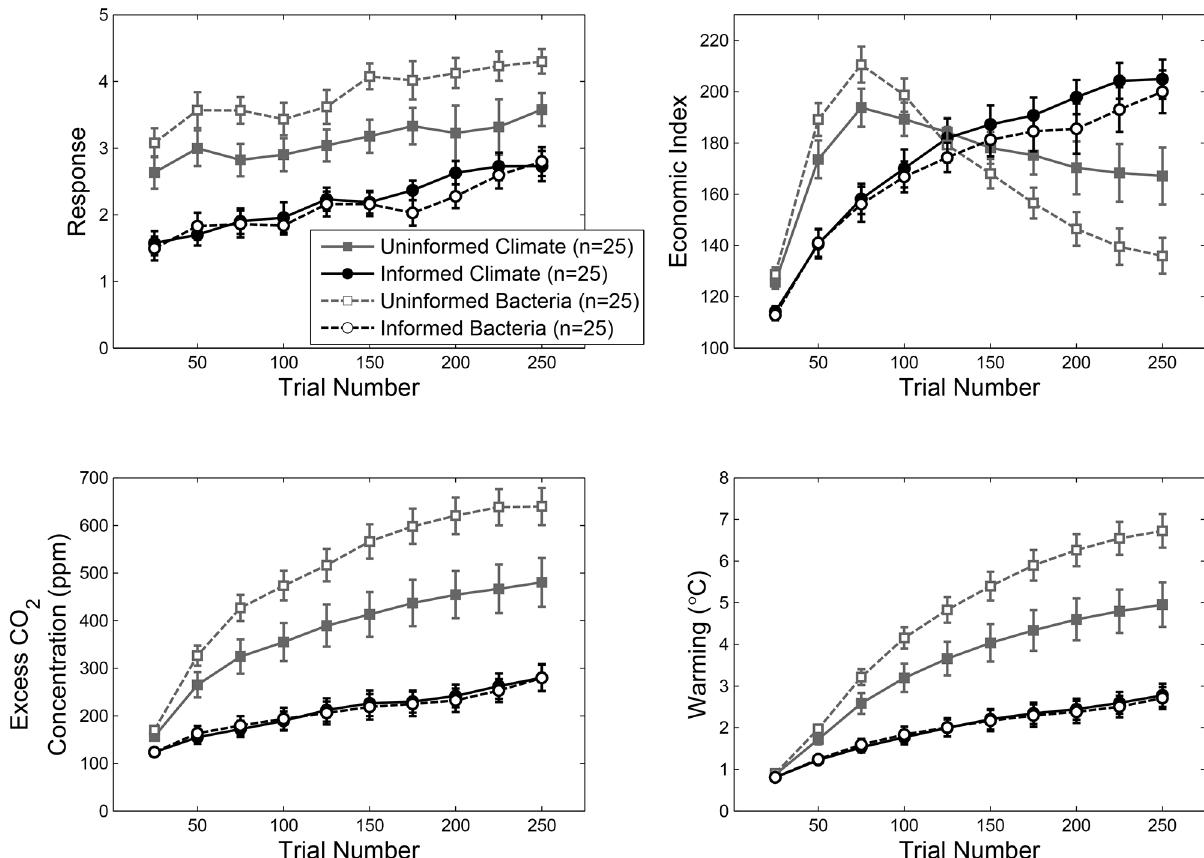
Fig 3. Data from Experiment 1. Panels show group averaged data for participantresponses (a), economicindex (b), excess CO 2 concentration (c), and warming(d). Error bars are one standarderror of the mean.